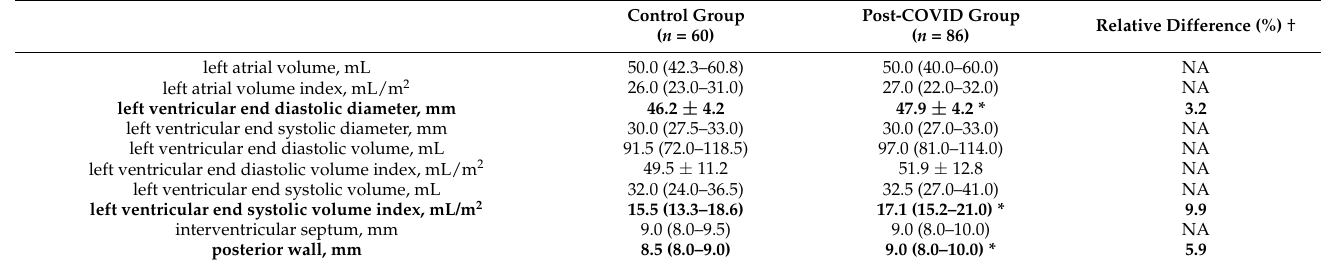
Table 2. Echocardiographic parameters of the left atrium and left ventricle in the study groups. Control Group ( n = 60) Relative Difference (%) † left atrial volume, mL